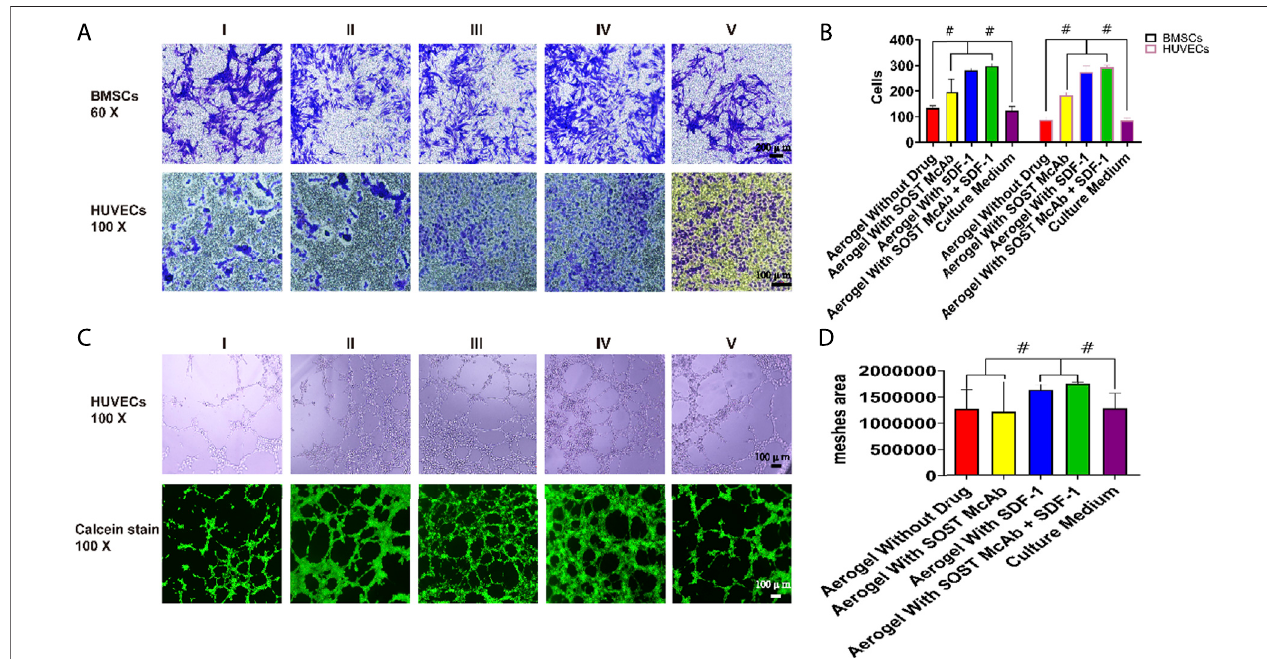
FIGURE5| TheresultsofTranswelltestandtubuleformationassay. (A,B) ResultsofcellstainingandcellcountinTranswelltest.TheTranswelltestshowsthatthe extractsofaerogelscaffoldscontainingdrugswerebetterthanthatofaerogelwithoutdrugsandcommonculturemedium.Eachbarrepresentsagroup,betterTranswell test results were obtained in the extract of drug-loaded aerogel scaffolds (C,D). The result of HUVECs tubule formation Assay. Calcein staining results showed that the aerogel scaffold with SDF-1 had the best effect of forming tubules, and the histogram of analysis ofmeshes area showed the same results, the difference between groupswasstatisticallysigni fi cant.GroupI,aerogelscaffoldwithoutloadingdrugs;GroupII,aerogelscaffoldloadedwithSOSTMcAb;GroupIII,aerogelscaffoldloaded withSDF-1; Group IV,aerogel scaffold loaded with SOSTMcAb +SDF-1; Group V,the control group with simple culture medium. BMSCs, bone marrow mesenchymal stem cells; HUVECs, Human umbilical vein endothelial cells. #, p ＜